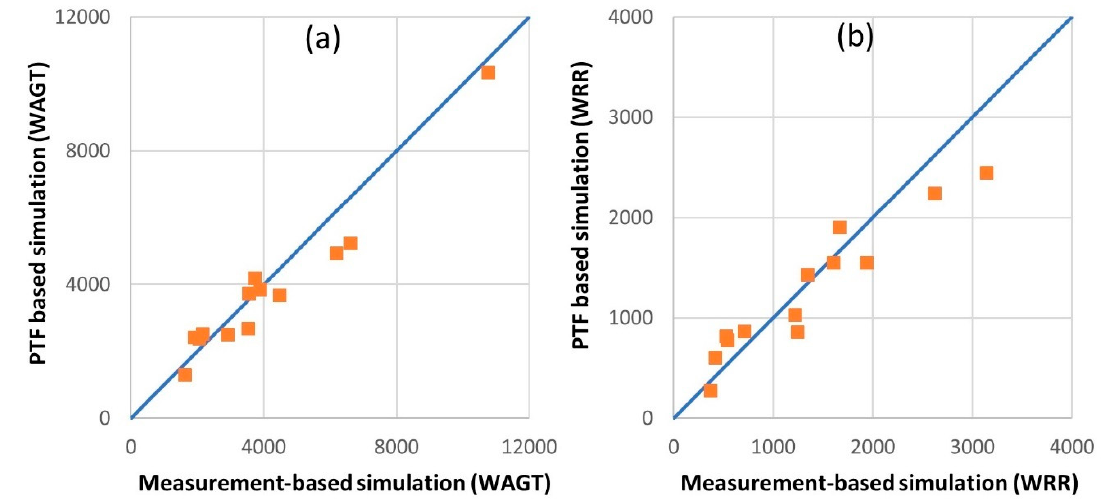
Figure 5. Relationship between measurement-based and PTF-based simulations of average yields